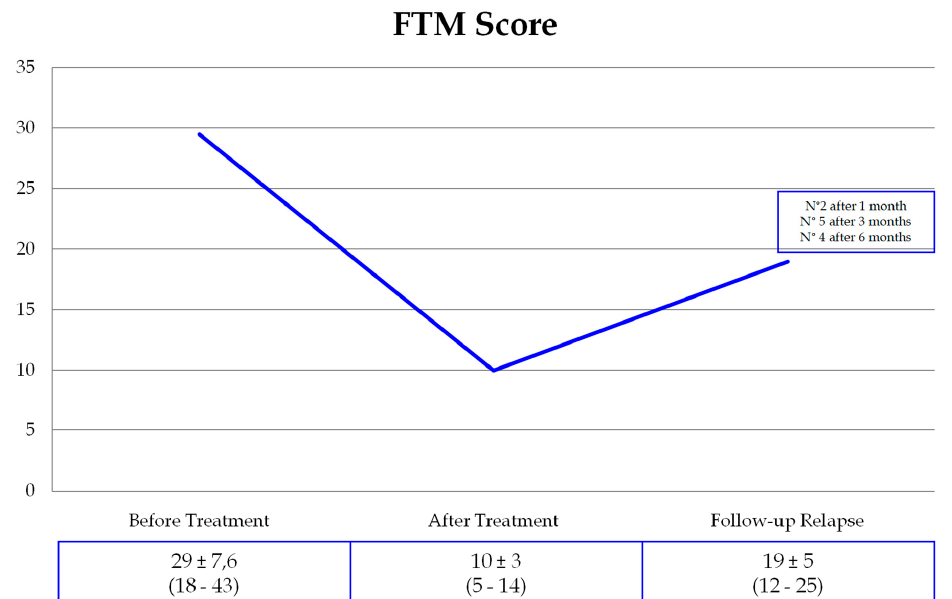
Figure 2. FTM scores in the study group.